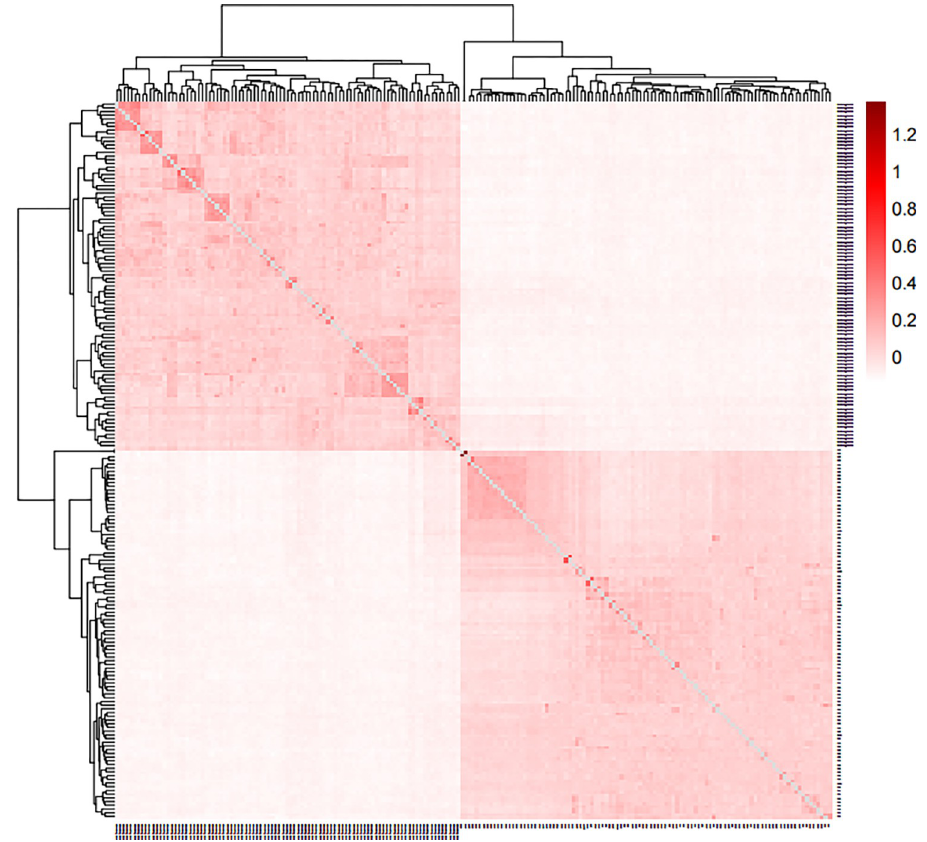
Fig 1. Heat map of genetic relationship matrix between Qira Black sheep and German Merino